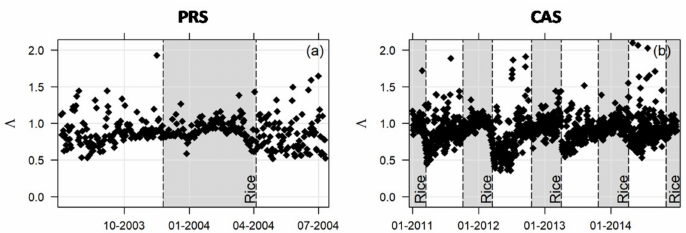
Figure 3. Daily average of evaporative fraction during fallow and flooded rice growing seasons (shadowed areas) at the PRS ( a ) and CAS ( b )